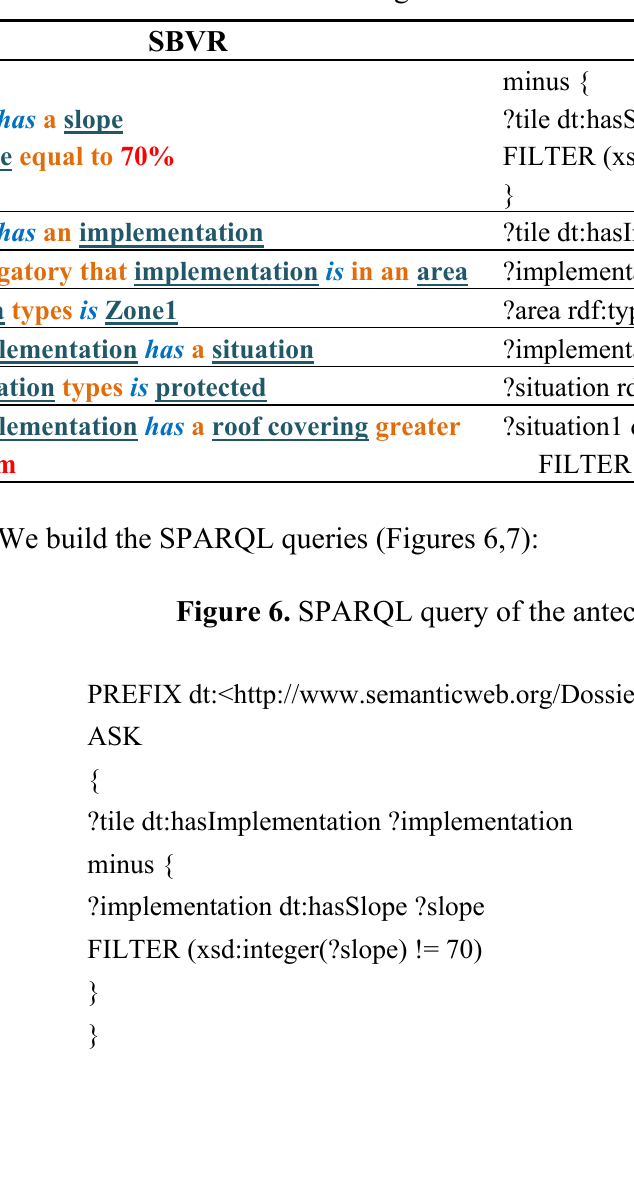
Table 2. Transforming SBVR rules into SPARQL triple pattern.